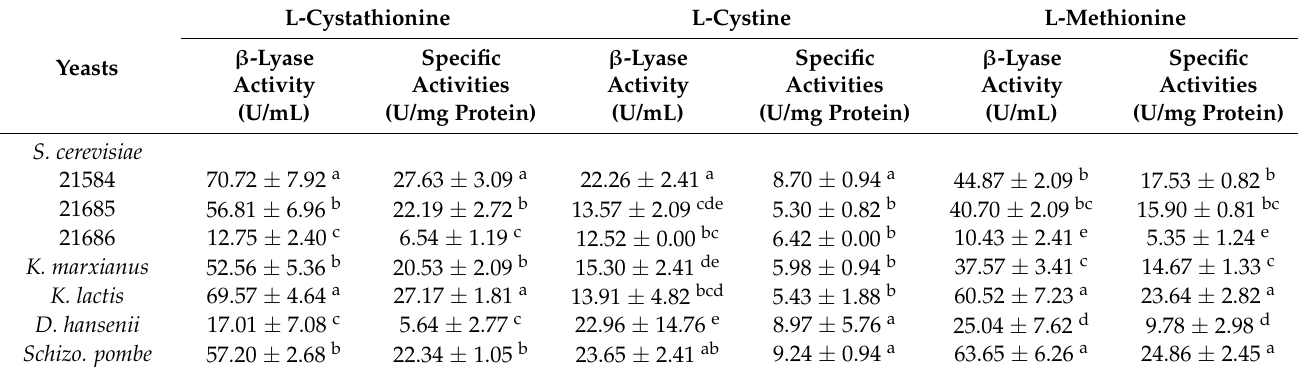
Table 1. The β -lyase activities for various substrates by various yeast crude